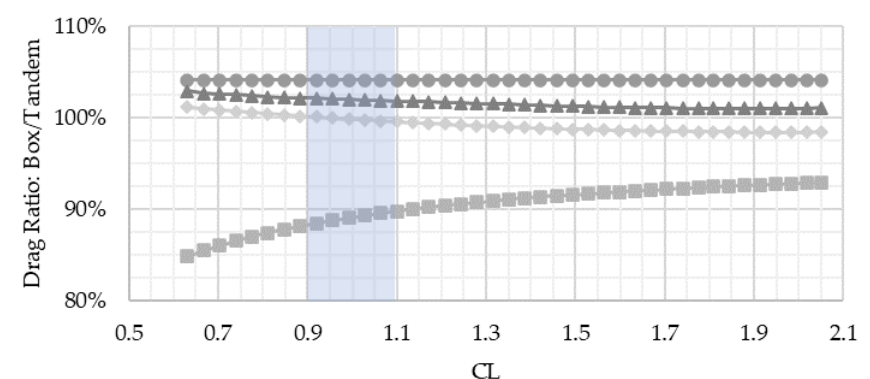
Figure 14. Aerodynamic comparison between box-wing and tandem-wing configurations.